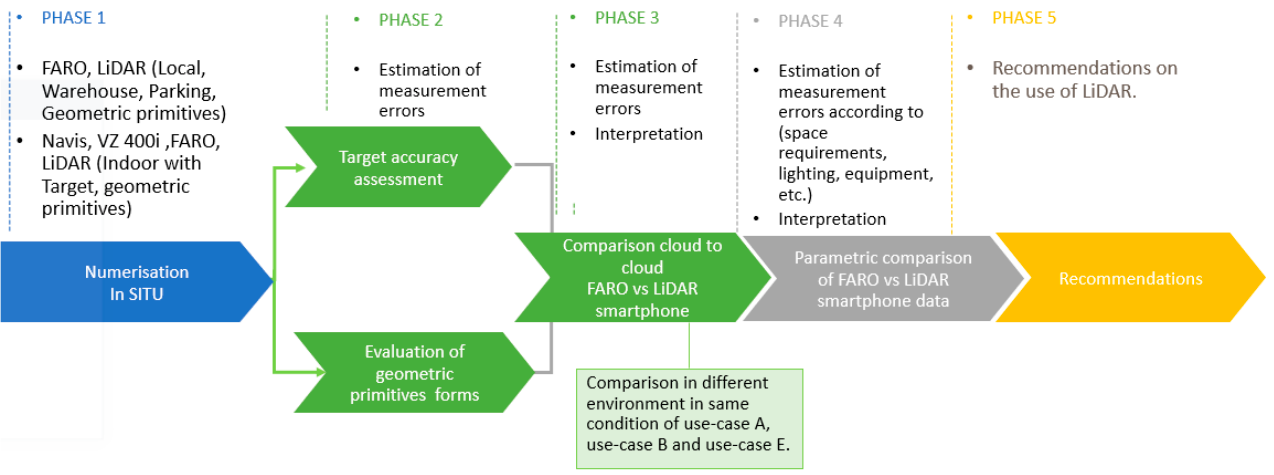
Figure 6. In Situ Experimental Protocol.